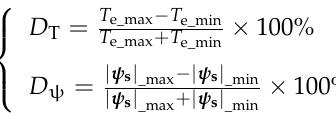
( b ) case 2 Figure 11. Performance evaluation indicators for case 1 and case 2. From Figure 11, under large neutral point potential conditions, the D T , D ψ and I THD of MPCC3 are all lower than those of MPCC1 and MPCC2, which verifies that the steady state performance of the improved MPCC is superior to that of conventional MPCC. 4.2.3. Control Performance under Dynamic State Under sudden change conditions (case 3: T L = 0 N·m → 5 N·m, n r = 500 r/min), the ex- perimental results of the stator current i A , electromagnetic torque T e , amplitude of stator flux | ψ s | and neutral point potential v o are shown in Figure 12.